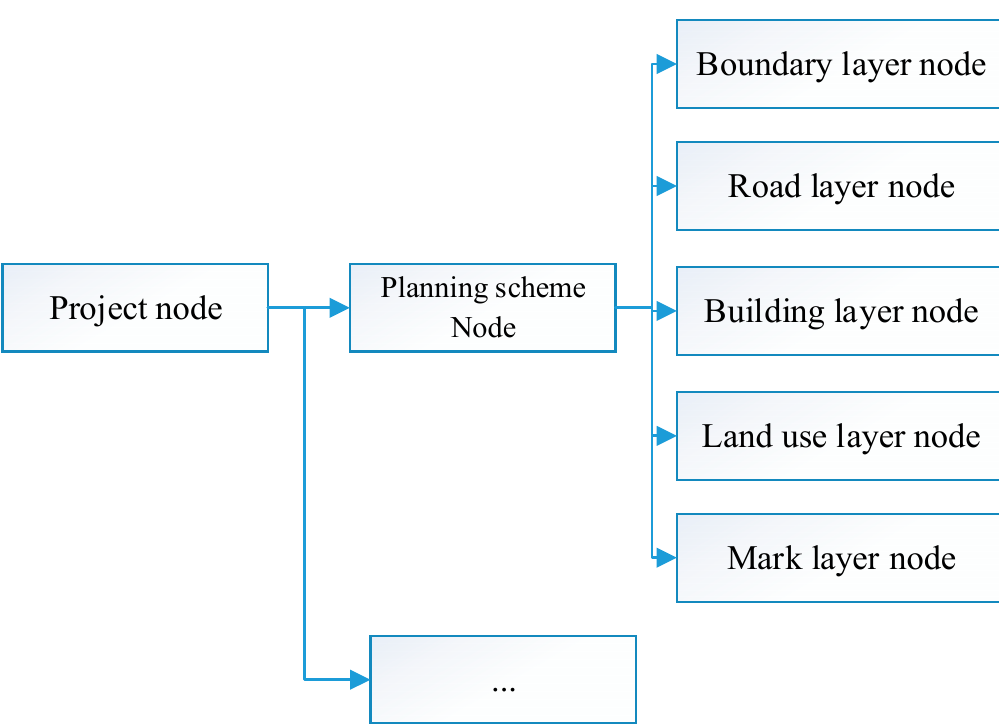
Figure 6. The data organization structure for the participatory rural planning project.